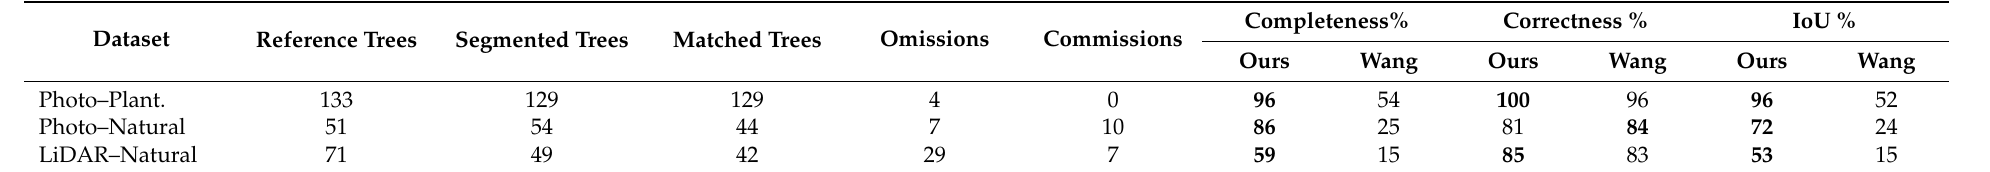
Table 6. Tabulated segmentation results achieved by our UCRP algorithm, and comparison of our algorithm to the SOTA algorithm [15] on the Photogrammetry and LiDAR Datasets. Bold indicates the best